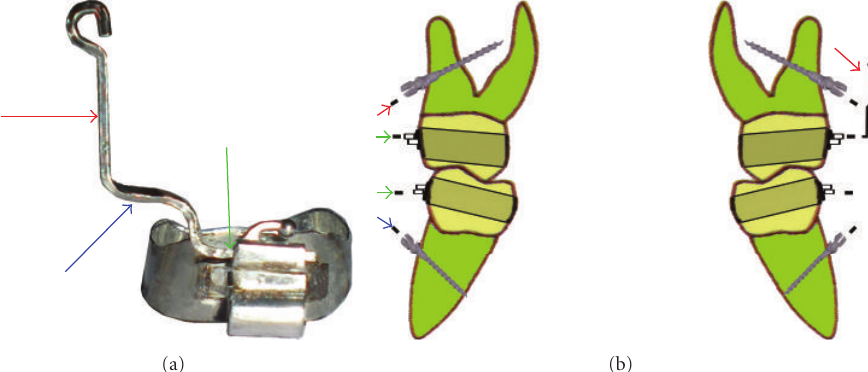
Figure 4: (a) MSPA consists of three parts: vertical-hooked arm (red arrow), horizontal middle part (blue arrow), and distal straight end section inserted in auxiliary molar tube (green arrow). (b) Place 1st- and 3rd-order bends as required in middle horizontal section of MSPA so that it passively engages the slot of miniscrew with insertion of distal end section into auxiliary molar tube.